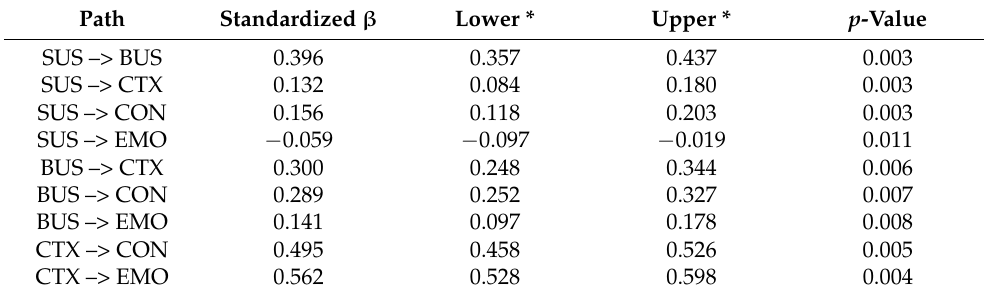
Table 3. Standardized direct